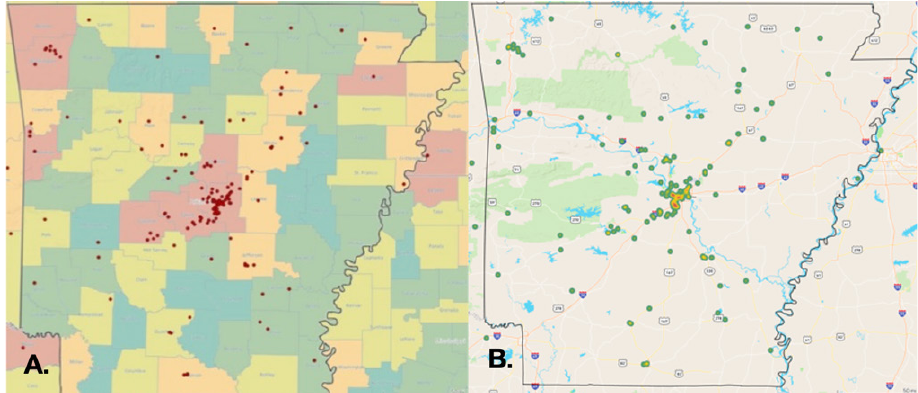
Figure 3. Geographic distribution of Arkansas CTCL patients’ residences by county ( A ) and along major interstates ( B ).